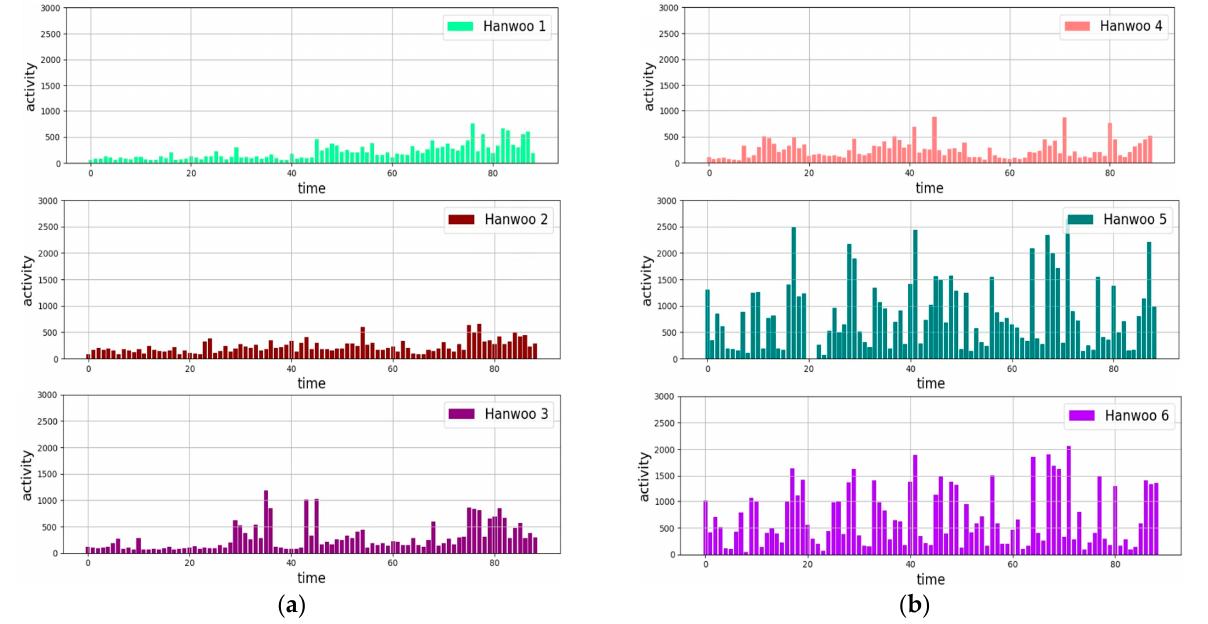
Figure 11. Activity data of individual Hanwoos: ( a ) Group A; ( b ) Group B.